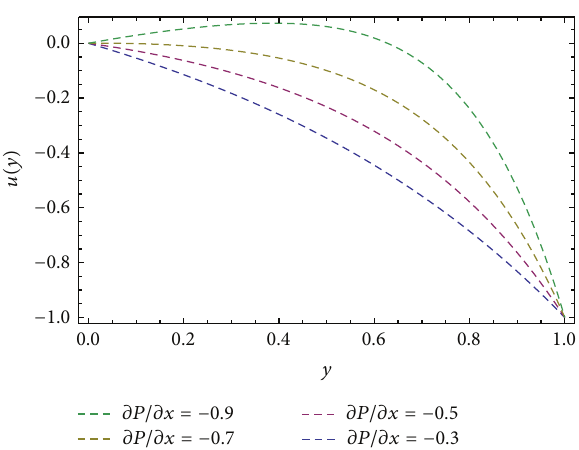
Figure 4: Velocity profile 𝑢(𝑦) for different values of 𝛽 , keeping 𝜕𝑃/𝜕𝑥 = −0.5 , 𝛼 = 1.0 , and 𝜙 = 45 ∘ .